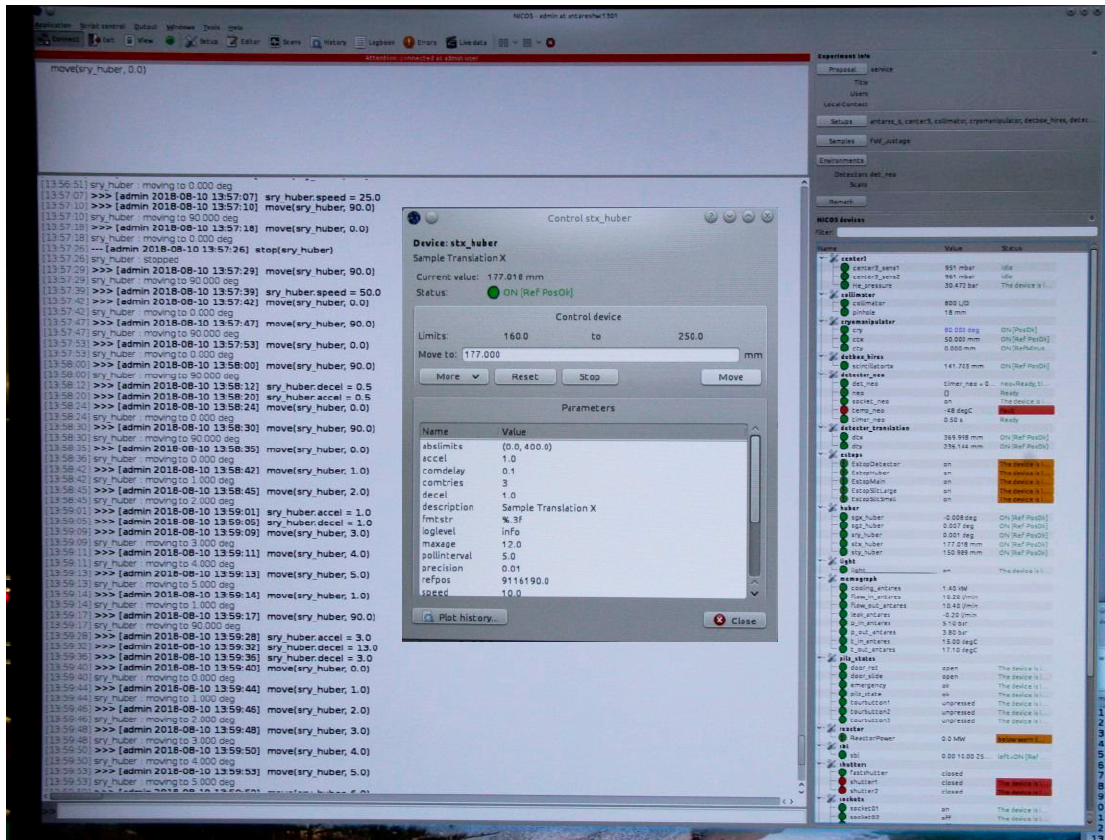
Figure 8. Screenshot of NICOS control software with history, command line, a control widget for a motor axis, and the device list.